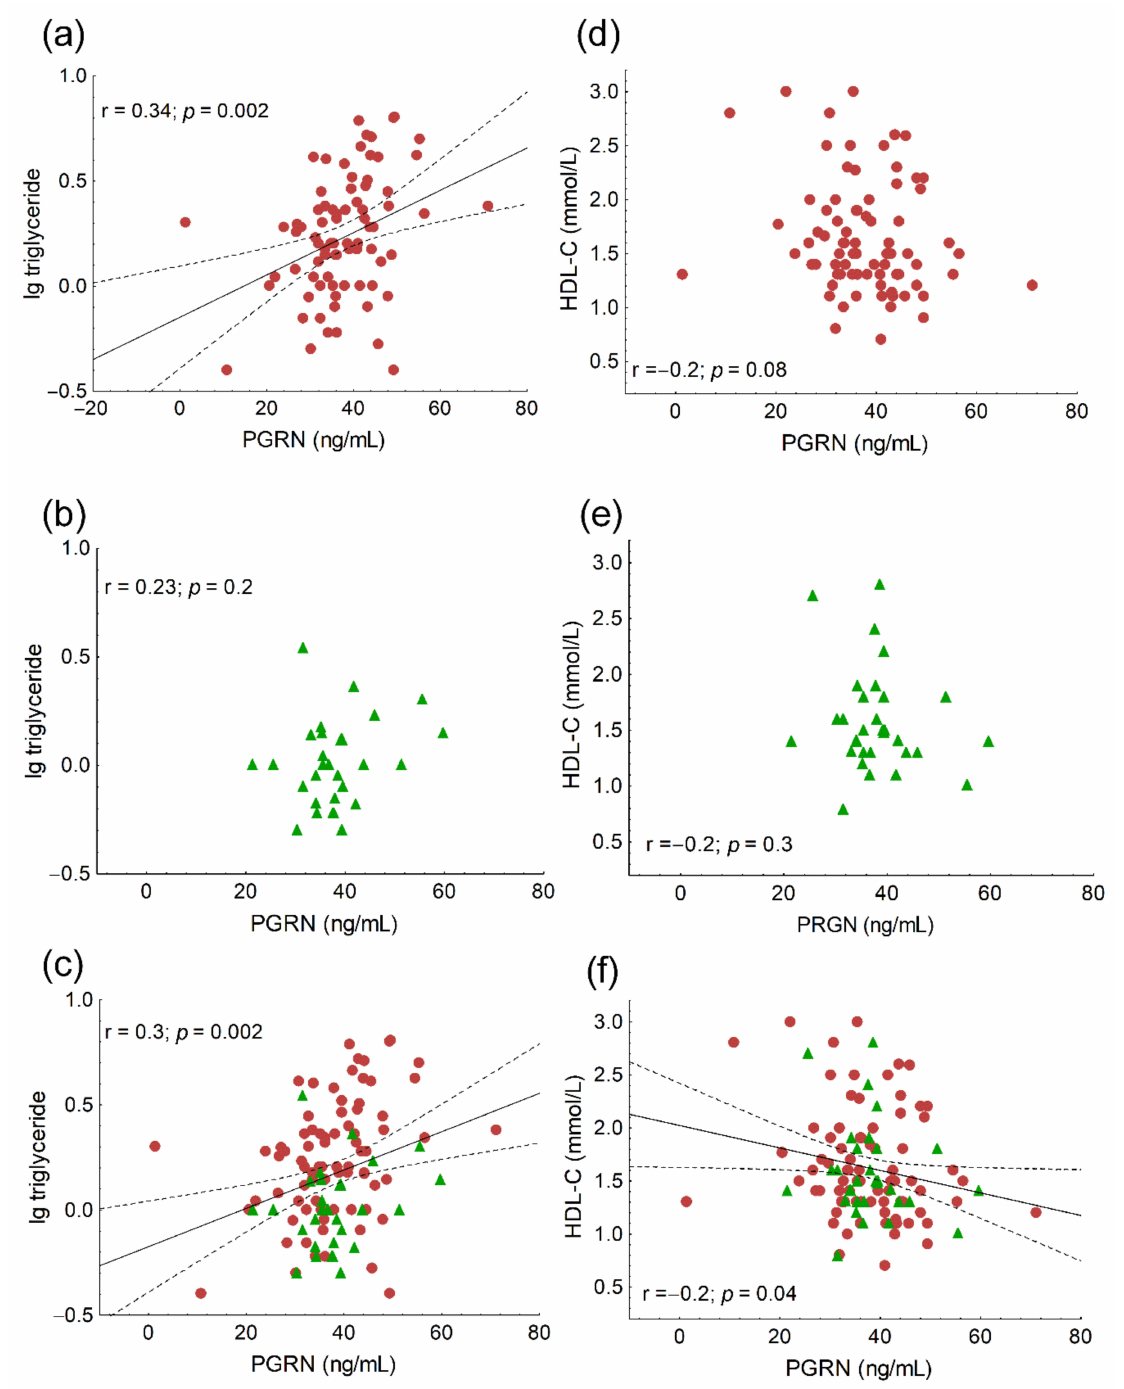
Figure 1. The correlations between serum triglyceride and progranulin (PGRN) in heterozygous familial hypercholesterolemic (HeFH) patients ( a ), healthy controls ( b ) and the whole study pop- ulation ( c ). The correlations between HDL-C and progranulin (PGRN) in heterozygous familial hypercholesterolemic (HeFH) patients ( d ), healthy controls ( e ) and the whole study population ( f